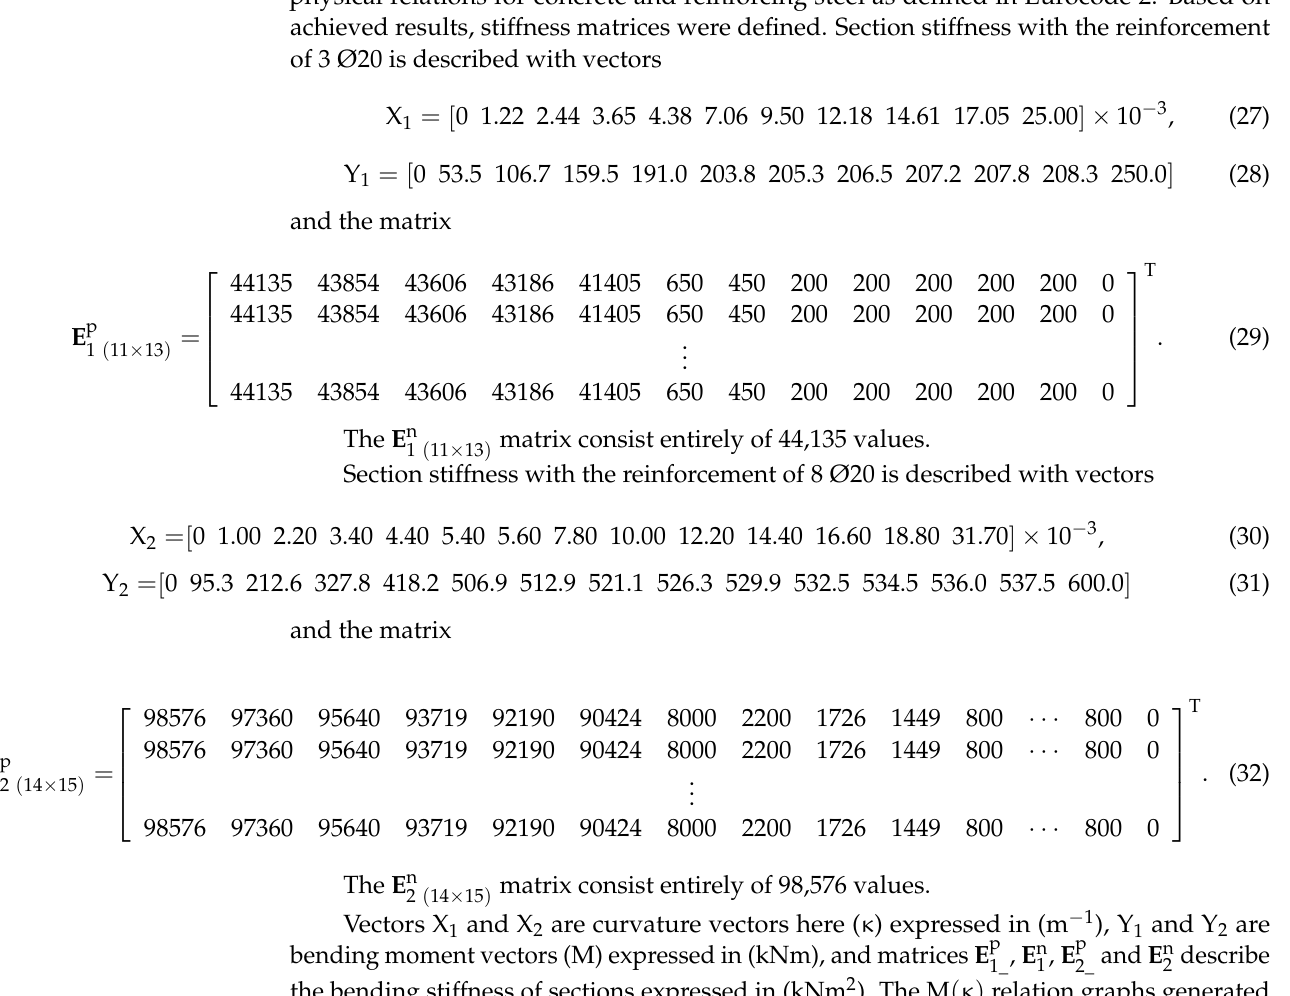
Figure 17. Static diagram of the beam being